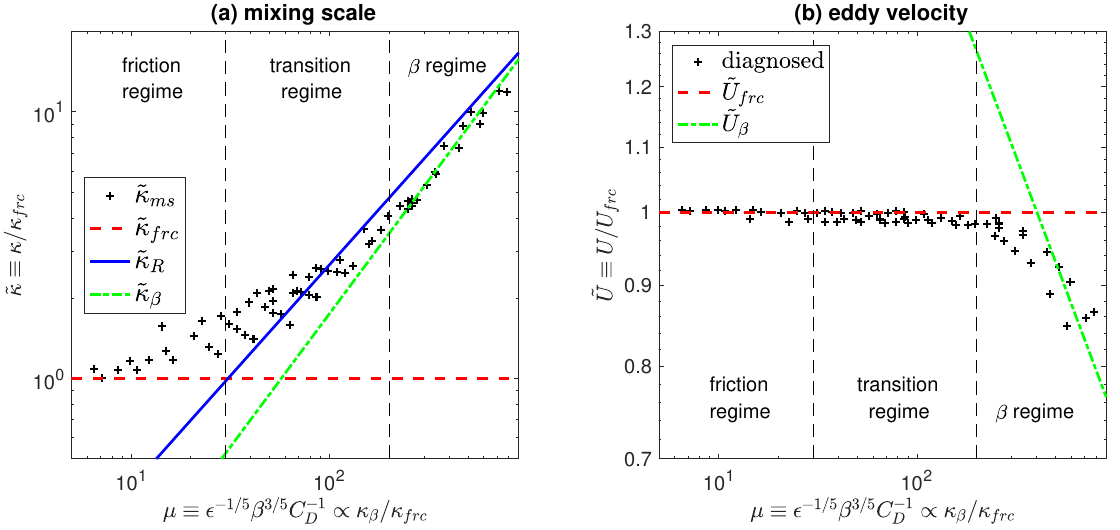
Figure 2. Testing the scaling expressions for the mixing scale and eddy velocity (defined here as the domain-averaged root mean square eddy velocity). The non-dimensional mixing scale ( a ) and eddy velocity ( b ) are plotted as a function of the non-dimensional parameter µ . Various scaling relations are indicated with colored lines (see legend and text). Vertical black dashed lines indicate the boundaries between different